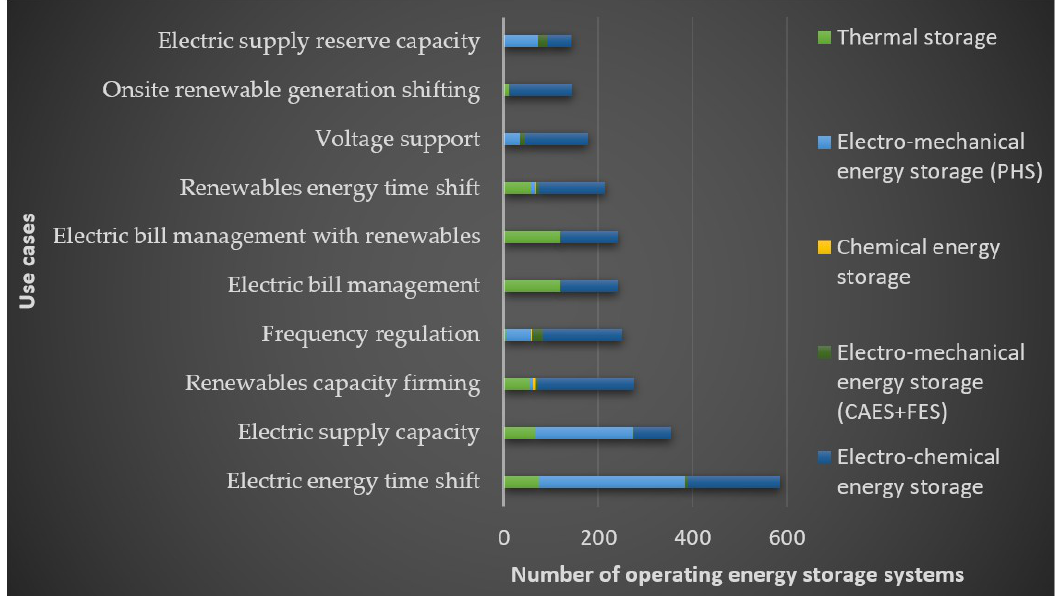
Figure 4. The 10 most common use cases of energy storage systems until August 16, 2016, based on [9] (Projects can have multiple use cases).